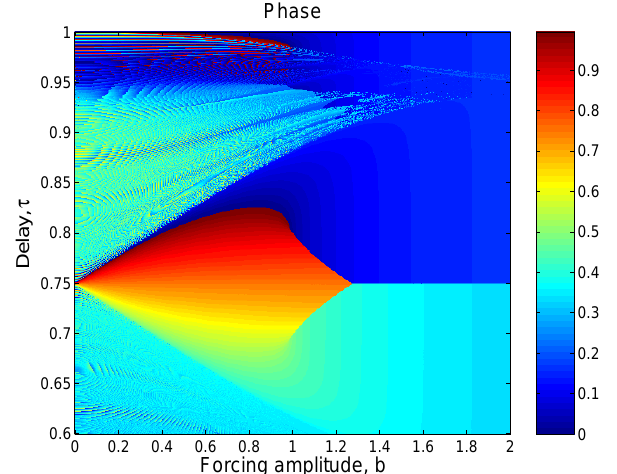
Fig. 7. Reversal in the phase locking of the maxima. The plot shows the seasonal cycle position ϕ of the global maximum for 250000solutions of Eq. (2), for κ = 11 . 0; it represents a blow-up of the region marked by a rectangle in the lower panel of Fig. 6.